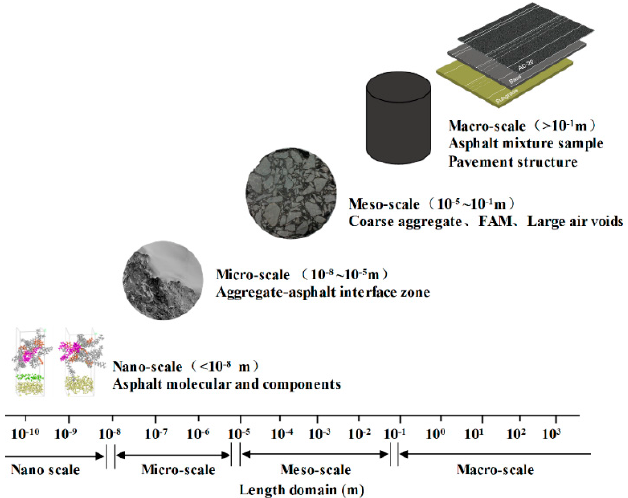
Figure 1. Scale classification of HMA: nano-scale, micro-scale, meso-scale and